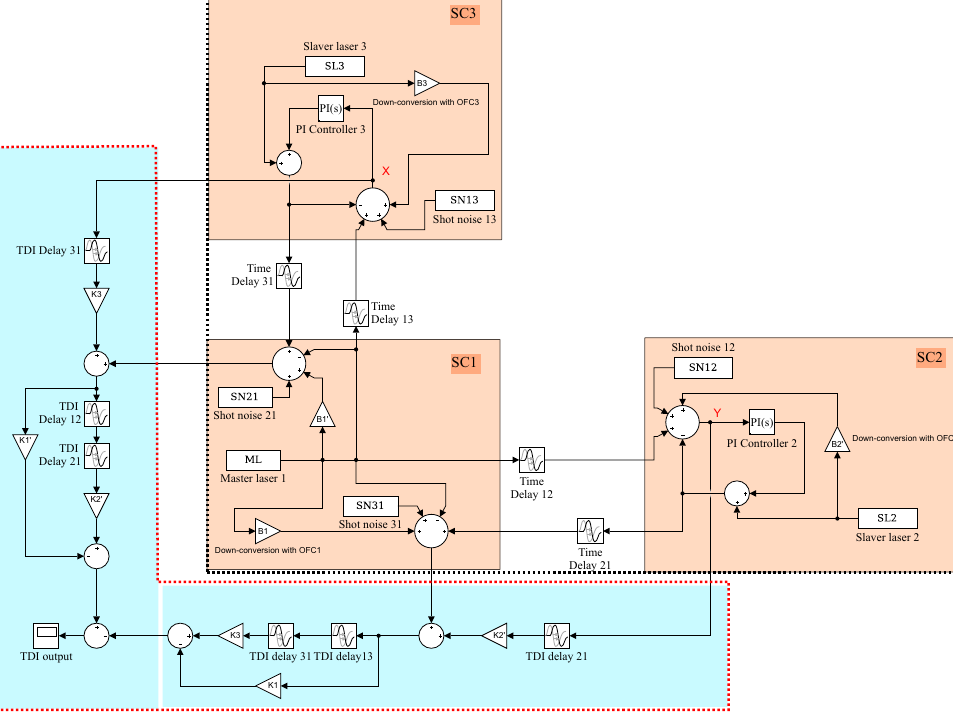
Figure 7. The block diagram of the time-domainsimulation in Simulink. SC: spacecraft.